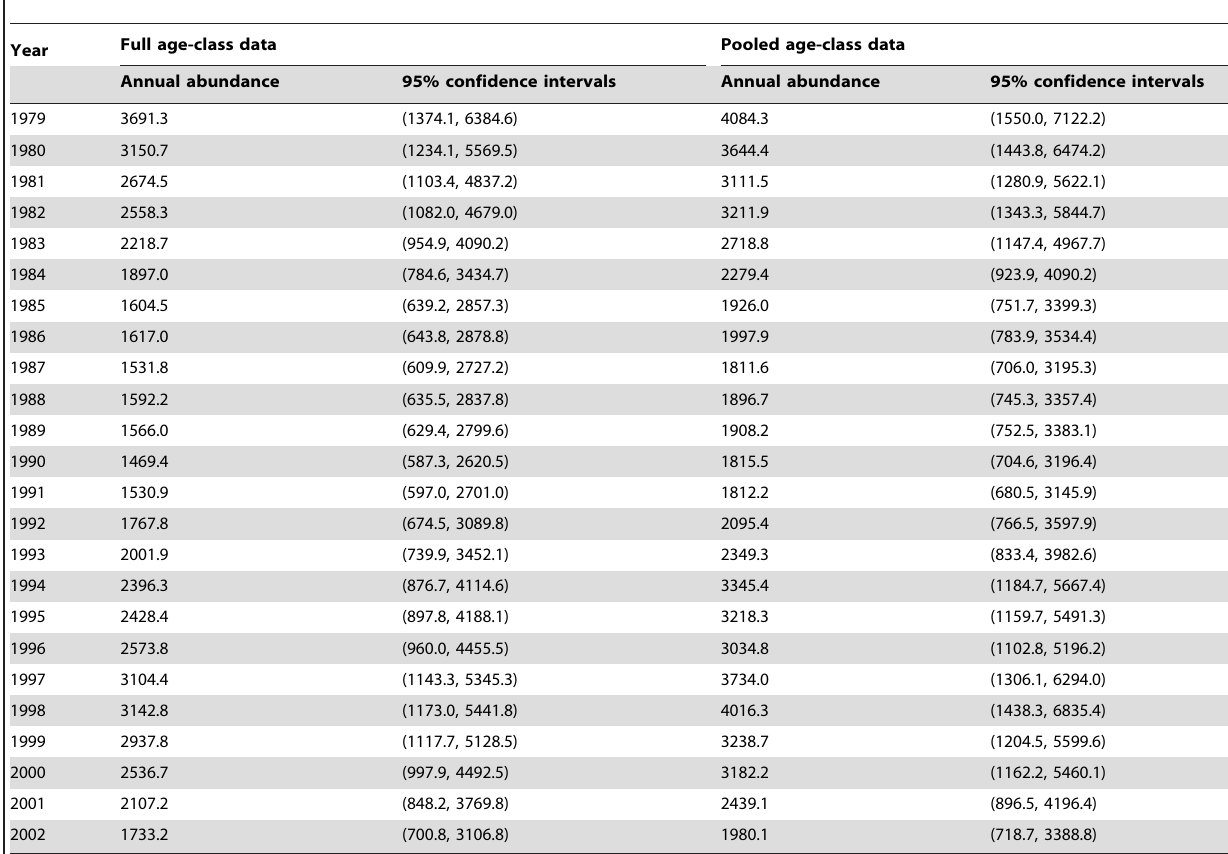
Table 3. Estimates of female black-tailed deer abundance by year in Pierce County, Washington, USA, 1979–2002, based on pooled adult and full age-class population